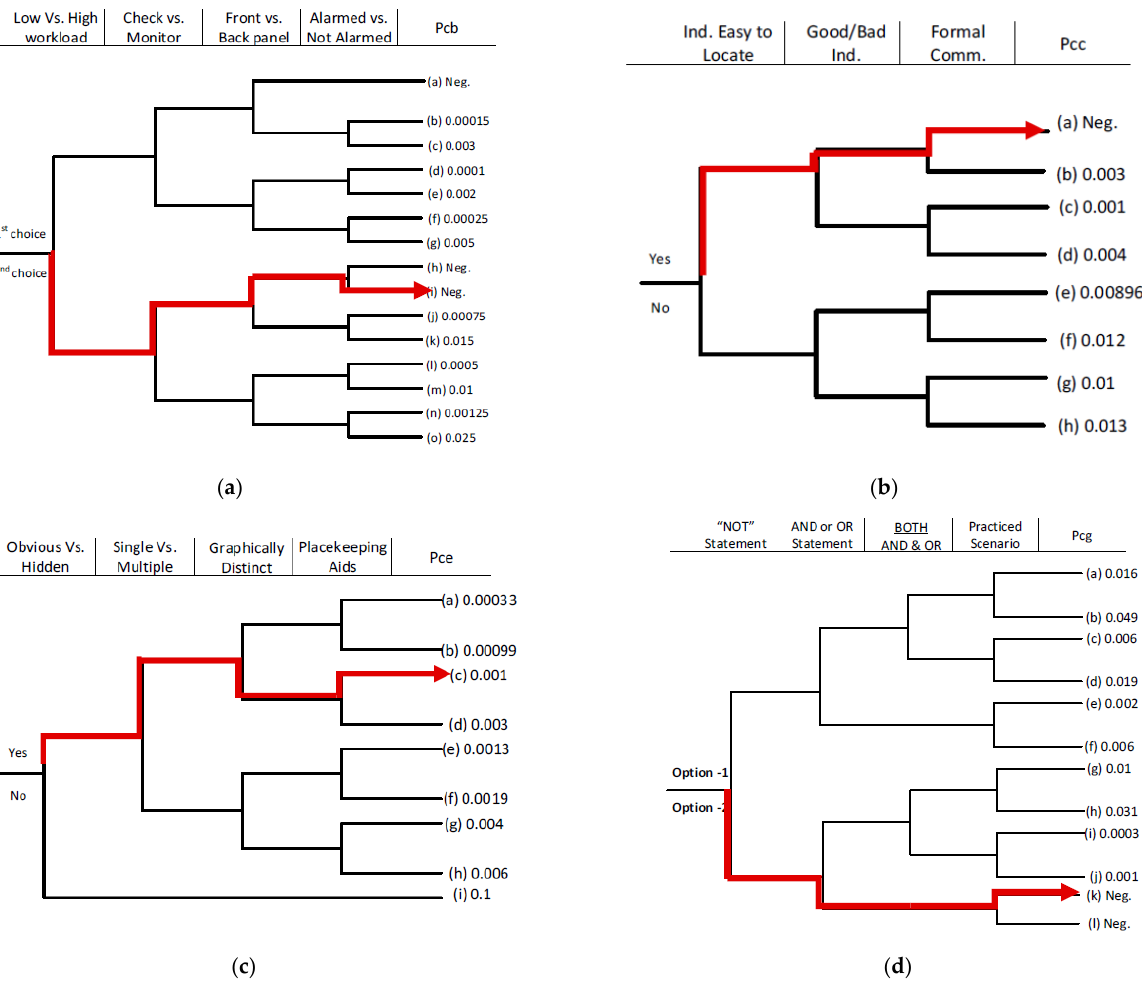
Figure 11. Branching paths in the modified trees. ( a ) Pcb; ( b ) Pcc; ( c ) Pce; and ( d ) Pcg for the evaluation in Table 7.